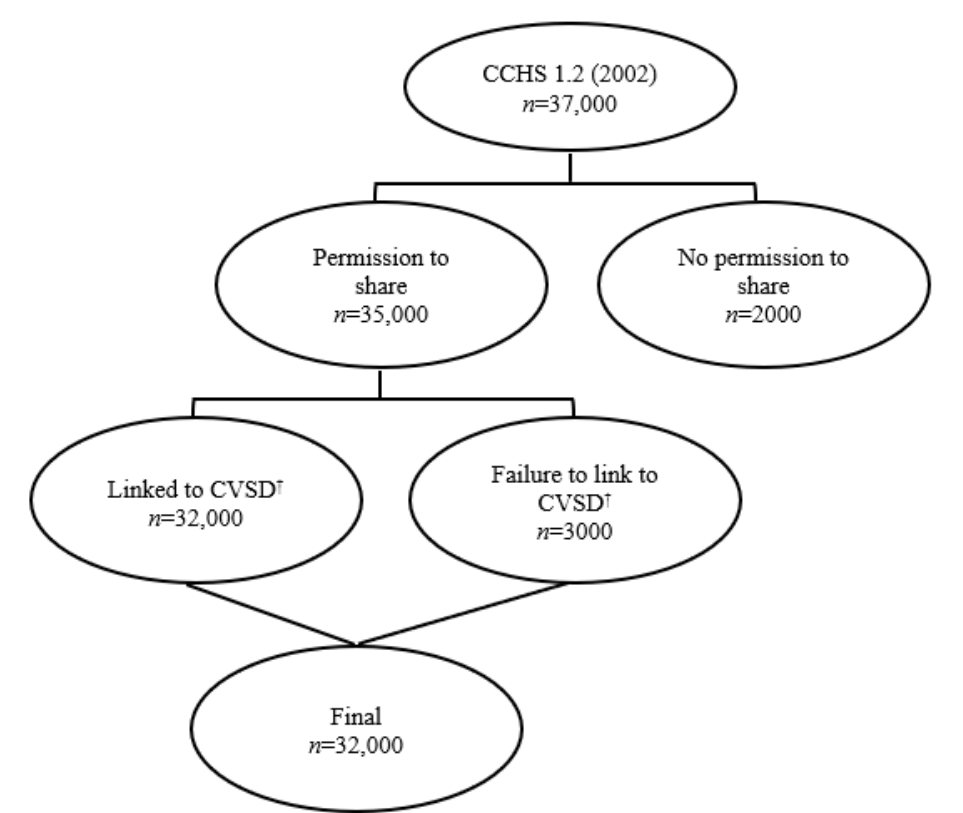
Figure 1. Flow diagrams for data linkage (estimates are rounded in keeping with Statistics Canada data release guidelines). † CVSD, Canadian Vital Statistics Database.